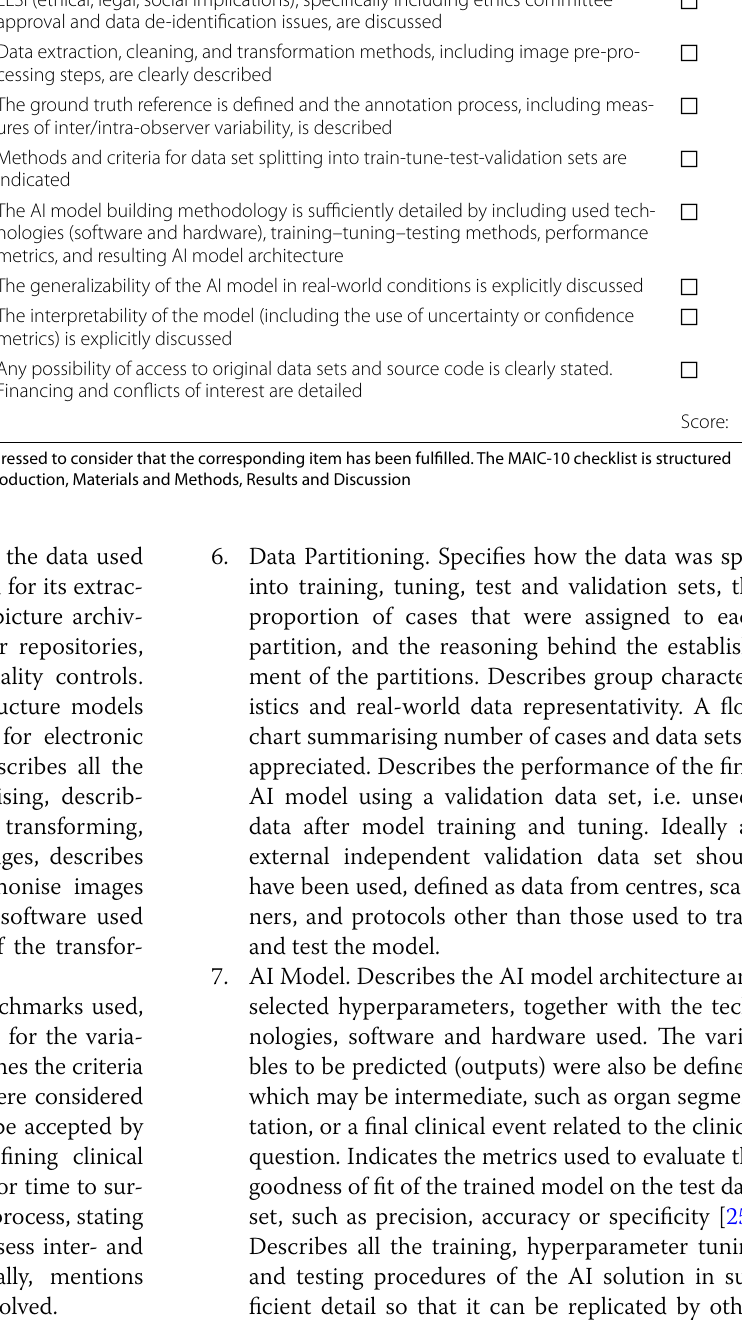
Table 1 MAIC‑10 checklist to assess quality of AI‑based medical imaging research studies